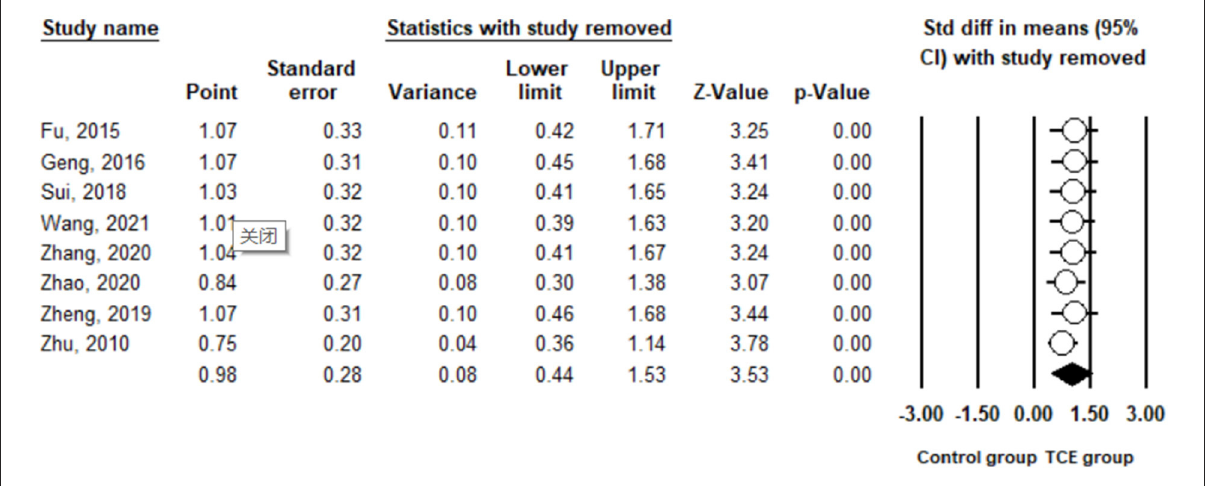
FIGURE6 Leave one out sensitivity analysis for anxiety.